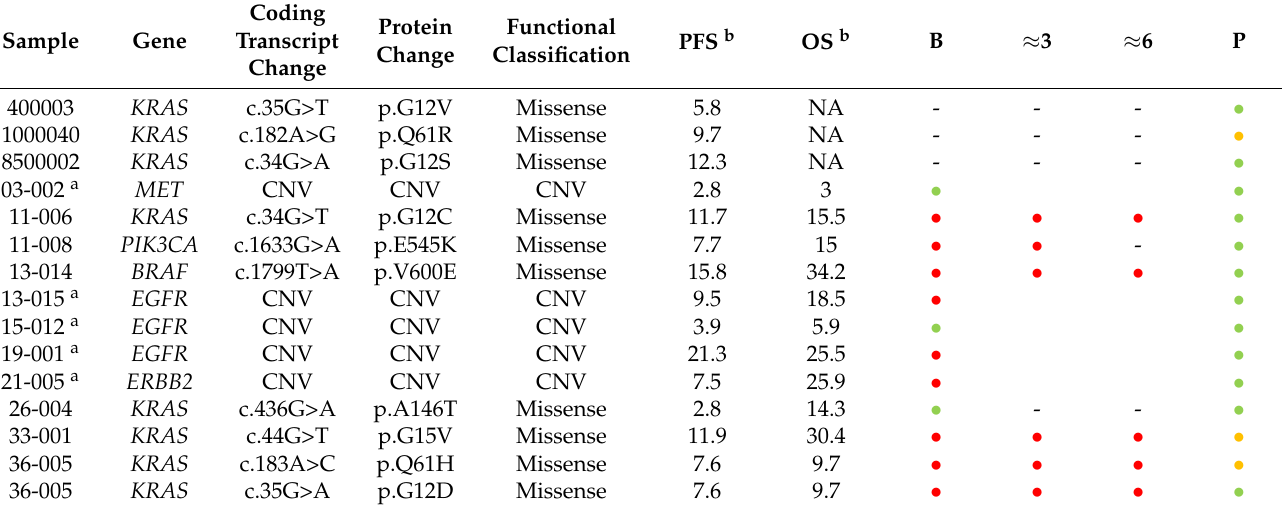
Table 2. dPCR Validation and retrospective tracking of oncogenic mutations detected upon dis- ease